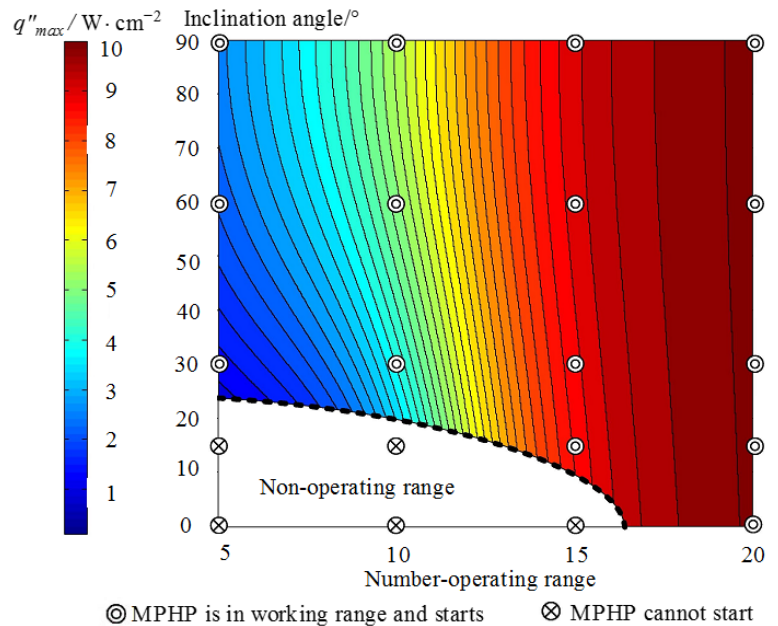
Figure 10. The maximum allowable heat flux density affected by gravity and turns number [109]. Lee et al.